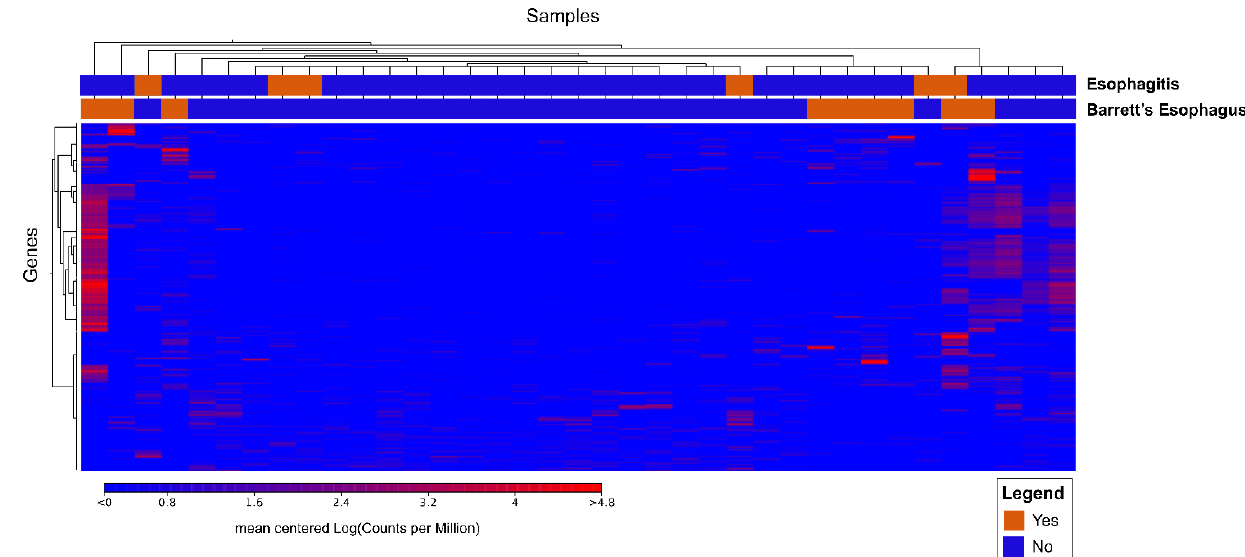
Figure 5. Cluster analysis data of 36 patients with and without Barrett’s esophagus. Many of these differentially expressed genes are involved in cell motility, apoptosis, stress response and biological processes typified in highly replicative malignant tissues. A partial number of these genes is listed in Table 4. For a complete list, see Supplementary Table S1 containing all differentially expressed genes. Table 4. Partial list of genes differentially expressed in Barrett’s esophagus compared to normal.